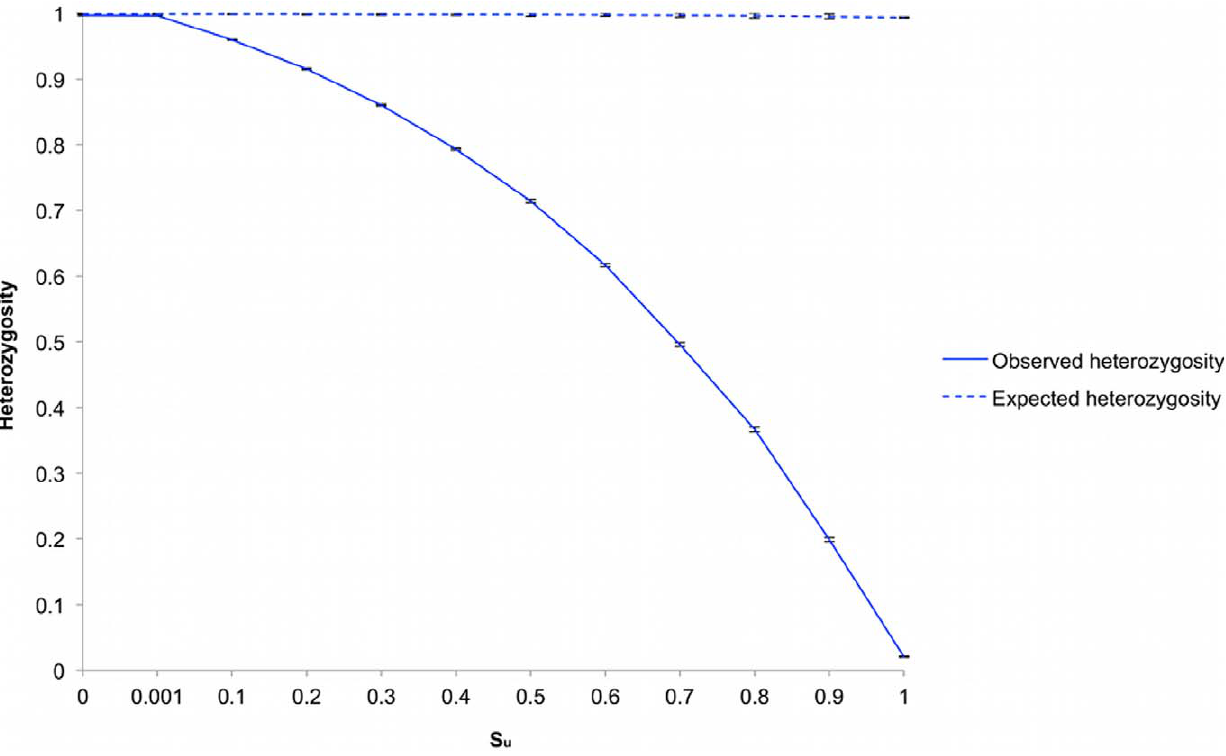
Figure 2. Heterozygosity as a function of selfing probability. H o is plotted with the solid line and H e using a dashed line. Simulations were repeated ten times. Error bars represent the standard error.